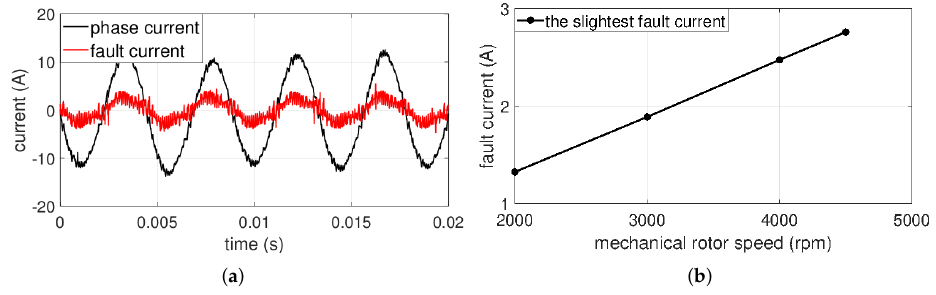
Figure 7. ( a ) Phase current and fault current at rated conditions and ( b ) the slightest fault current with mechanical rotor speed.